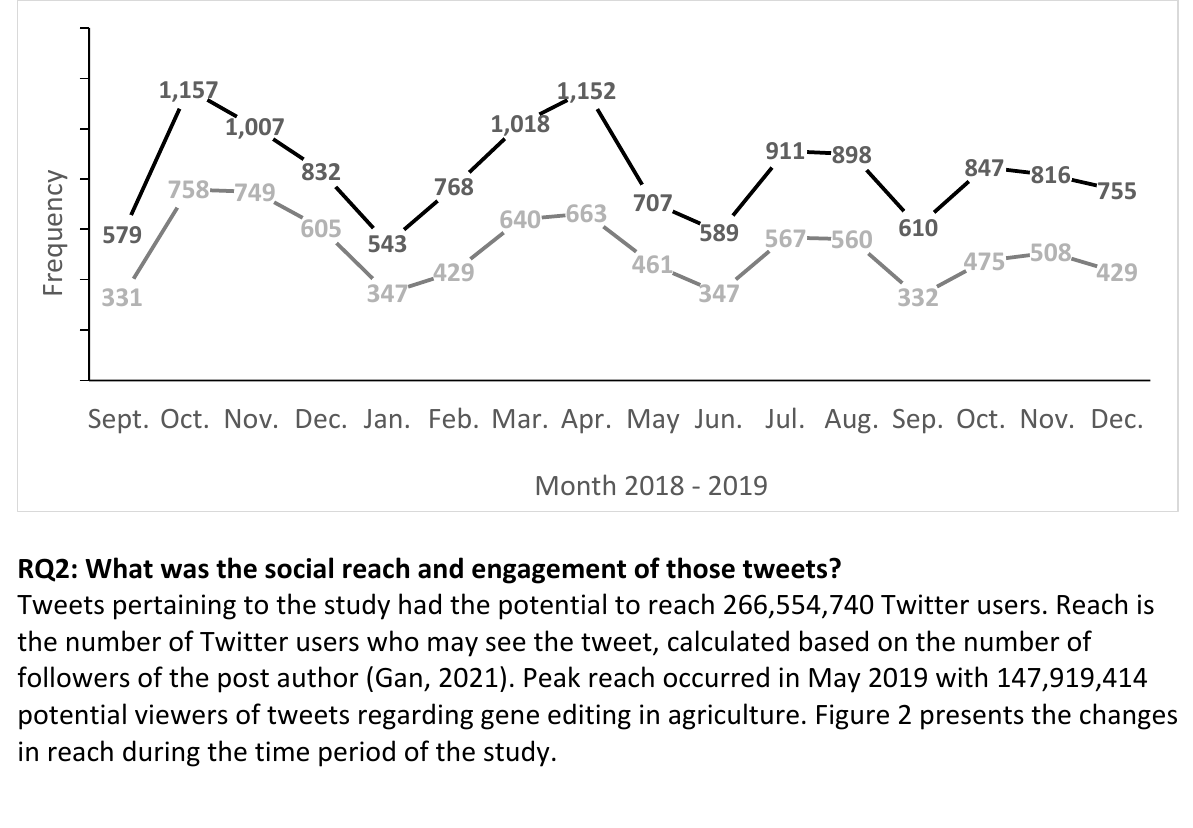
Frequency of Gene editing in Agriculture Tweets and Unique Twitter Users